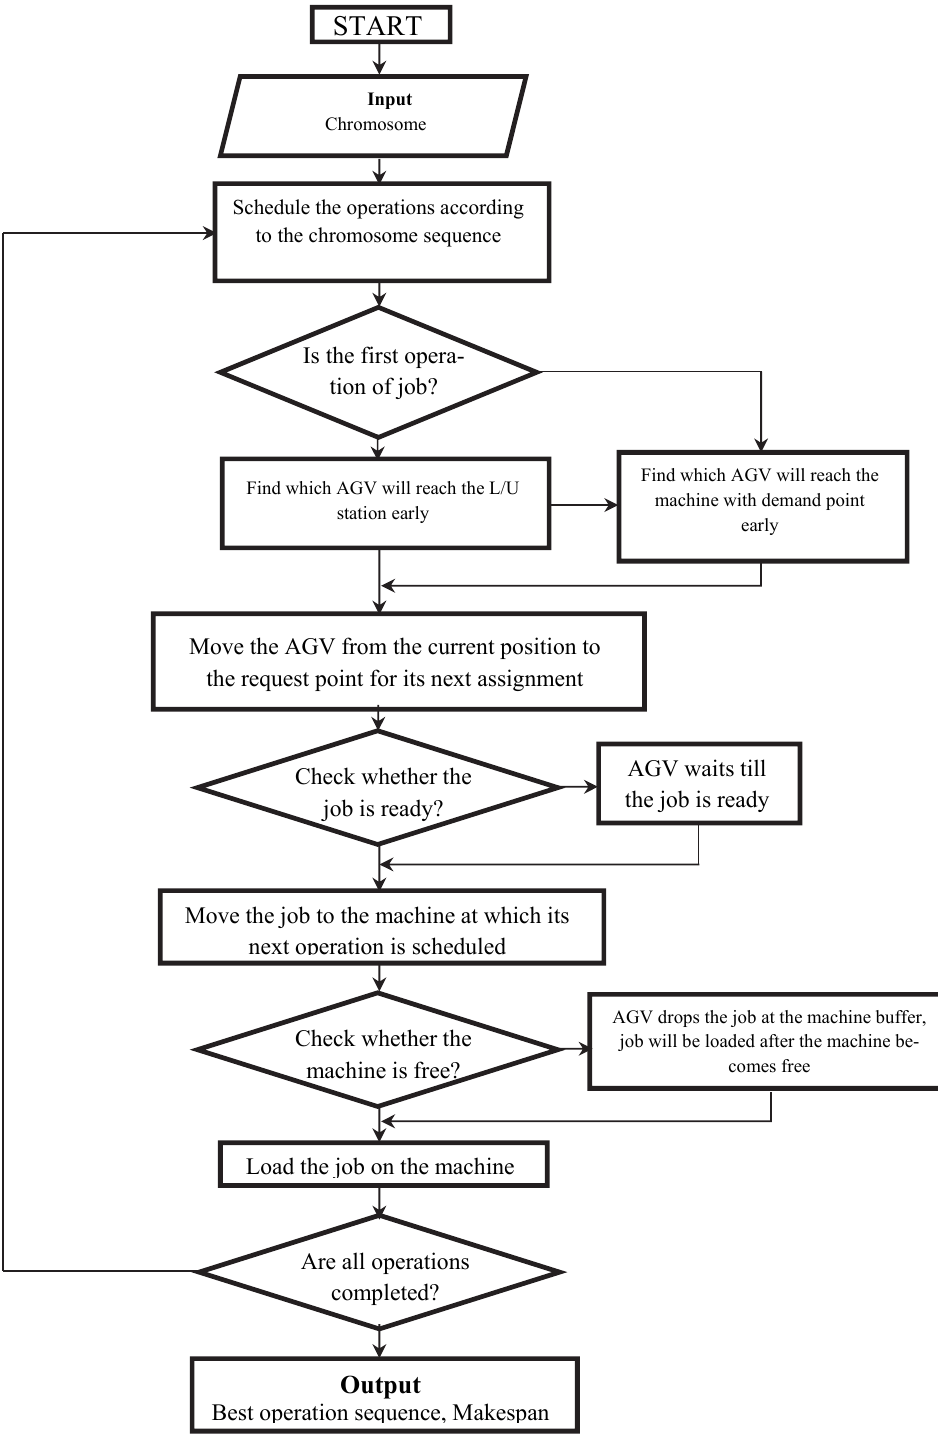
Fig. 1. Machine and automated guided vehicle scheduling flow